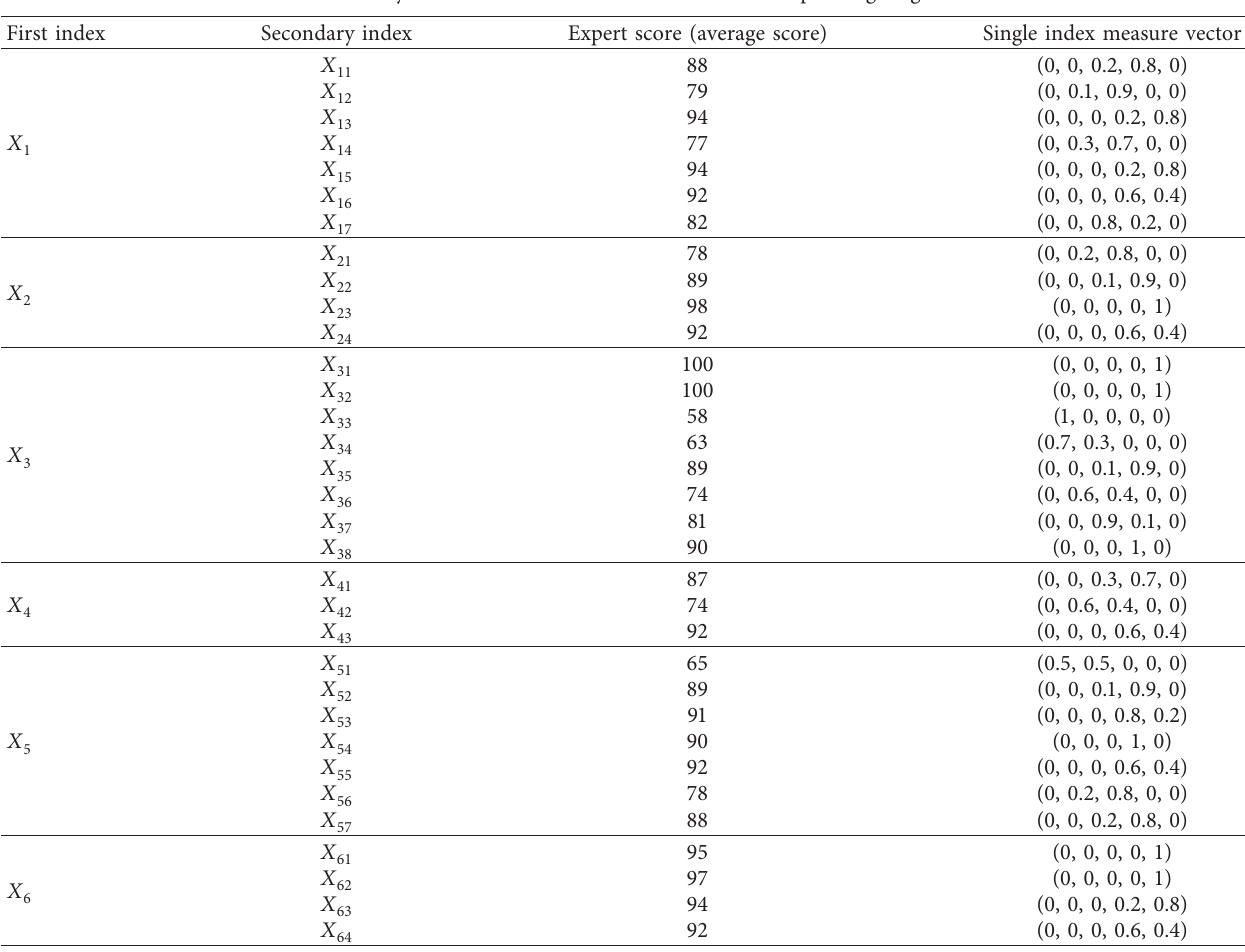
Table 4: Construction site safety risk evaluation index score and the corresponding single index measure vector.